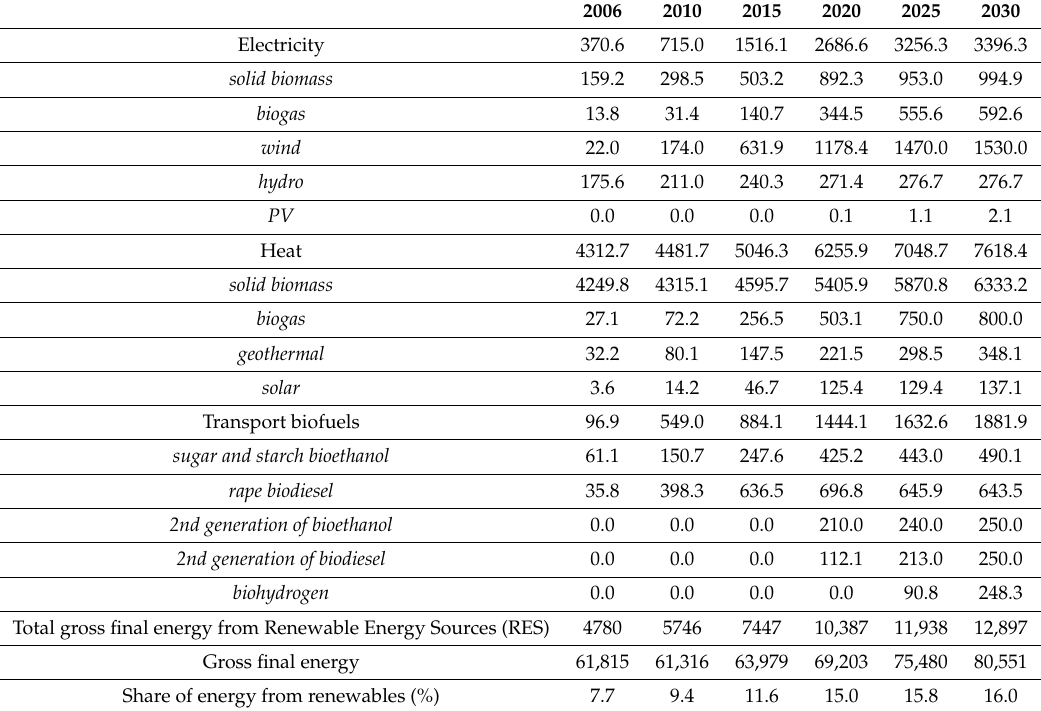
Table 3. Demand for gross final energy from renewables in Poland, ktoe (adapted from